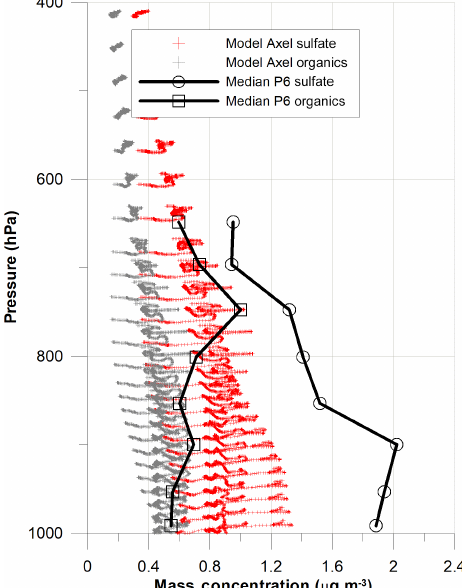
Figure 15. Vertical profile plot of mass concentrations of sulfate and of organics with pressure from the model for the Axel grid for 1–14 April (red crosses are sulfate and grey crosses are organics) and median values of the Polar 6 sulfate (open circles) and organic (open squares) mass